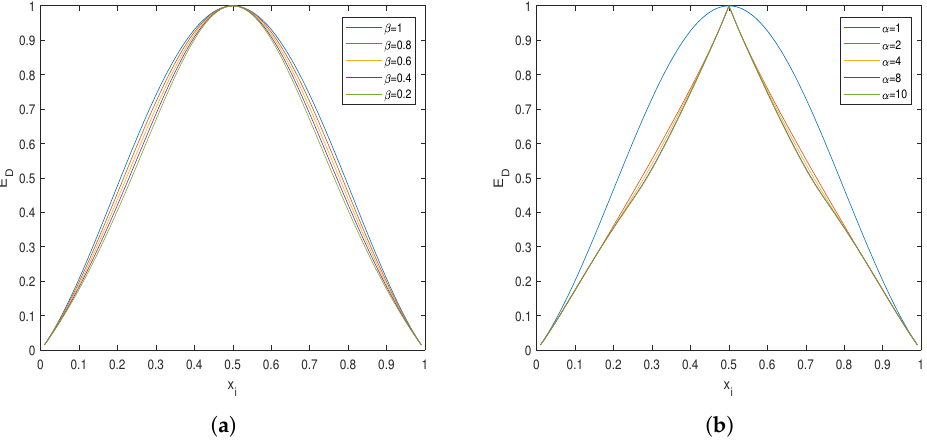
Figure 1. Proposed entropy measure for different α and β values for n = 2. ( a ) Entropy measure values for α = 1, and β = 1, β = 0.8, β = 0.6, β = 0.4. ( b ) Entropy measure values for β = 0.9, and α = 1, α = 2, α = 3, α =